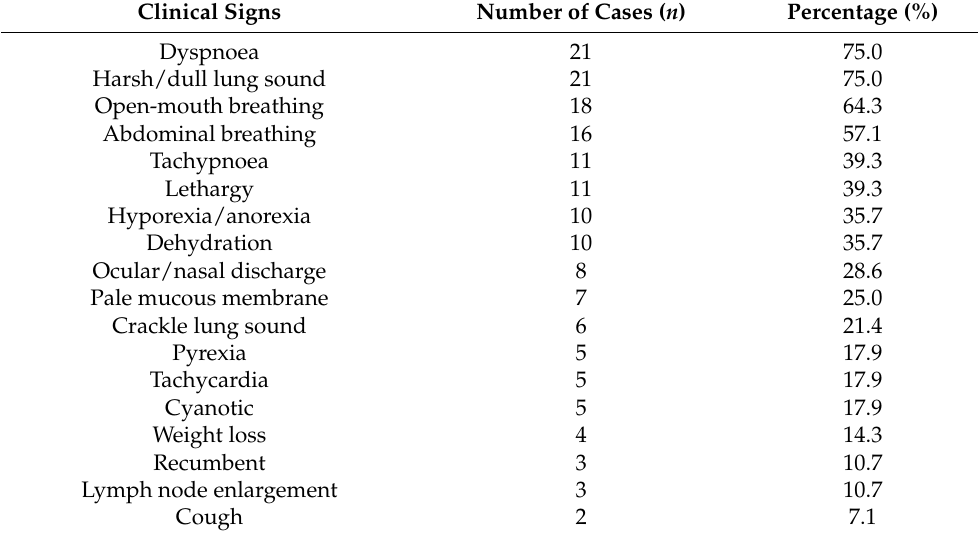
Table 4. Clinical signs of 28 cats with